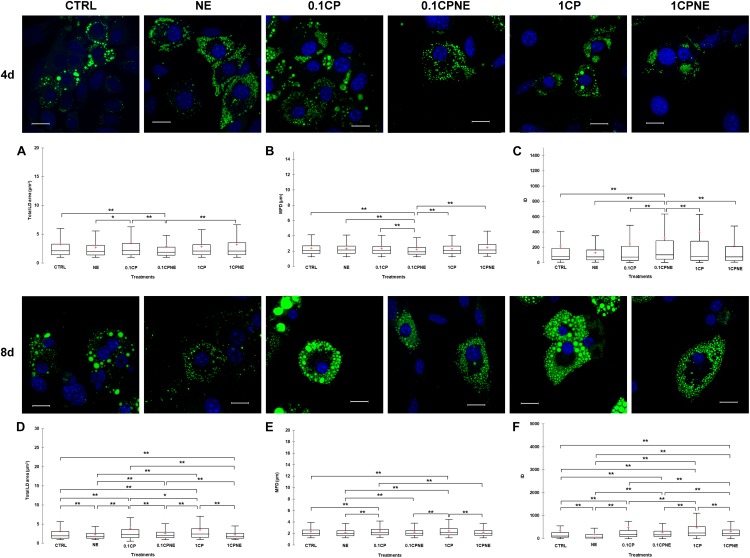
Lipid droplets formation stained with BODIPY 493/503 in fixed X9 cells at 4 and 8 days of differentiation. Nuclear staining DAPI. Images are representative of n. 5 biological replicates. (A–F) Lipid droplets box plots show median (horizontal lines), first to third quartile (box), and the most extreme values with the interquartile range (vertical lines). For all comparison, differences between treatments on X9 cells were statistically significant, using Kruskal–Wallis test. (A) Total LD area surface at 4 days; (B) Maximum Feret diameter (MFD) at 4 days; (C) Intensity optical density (IOD) at 4 days. (D) Total LD area surface at 8 days; (E) Maximum Feret diameter (MFD) at 8 days; (F) Intensity optical density (IOD) at 8 days. The area surface measures are expressed in μm2 and MFD μm. Measures are the average of 1824 and 1778 observations at 4 at 8 days, respectively. ∗∗p < 0.0001; ∗p < 0.05. Scale bars: 20 μm. CTRL = vehicle negative control; NE = 10 μM norepinephrine; 0.1CP = 0.1 μM capsaicin; 0.1CPNE = 0.1 μM capsaicin plus 10 μM norepinephrine; 1CP = 1 μM capsaicin; 1CPNE = 1 μM capsaicin plus 10 μM norepinephrine.